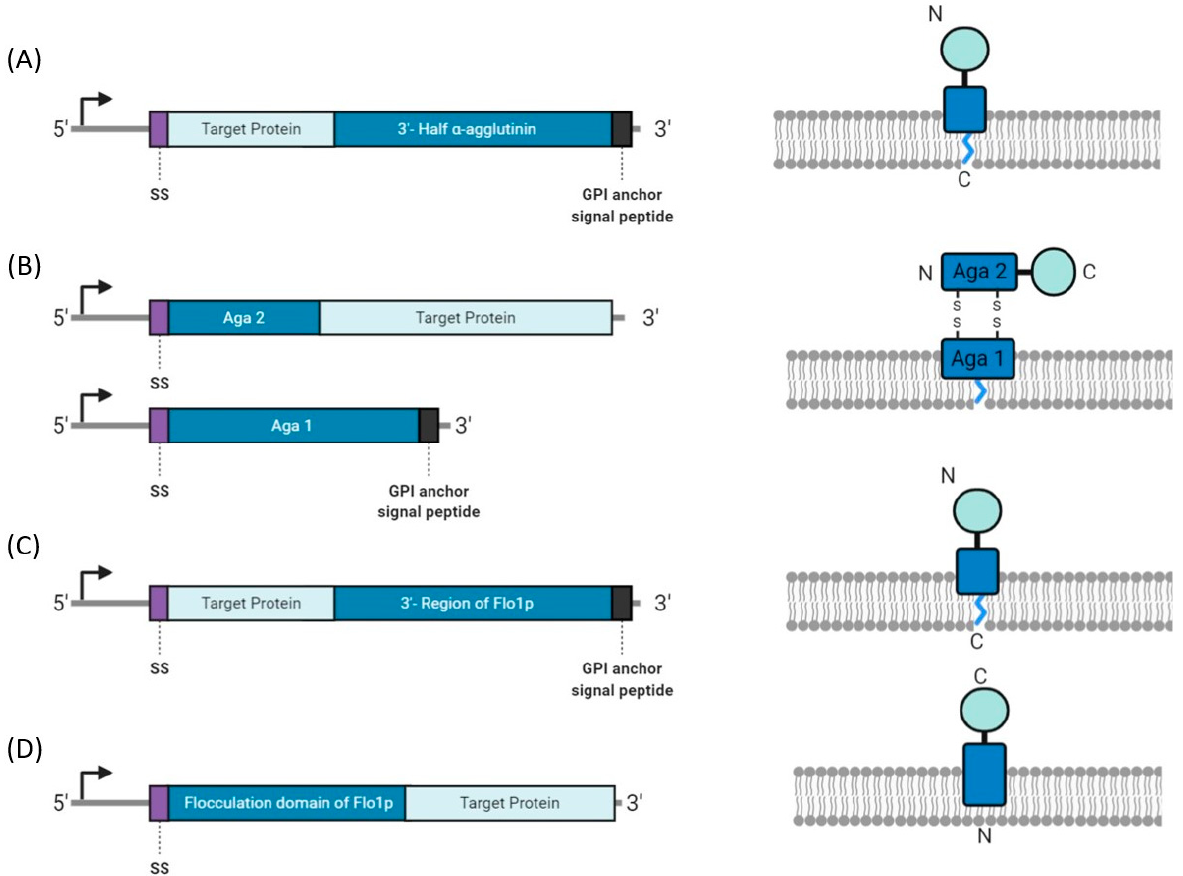
Figure 3. Construct designs for yeast display systems. ( A ) α -agglutinin is fused to the C-terminus of the target protein and anchored to the cell membrane by a glycosylphosphatidylinositol (GPI) anchor. ( B ) a-agglutinin (Aga) is a dimer, with Aga2 linked to the N-terminus of the target protein. Aga1 is membrane bound by a GPI anchor and forms disulfide bonds with Aga2. ( C ) The C-terminal domain of Flo1p is linked to the C-terminal region of the target protein. ( D ) The N-terminal domain of the Flo1p is linked to the N-terminal region of the target protein.